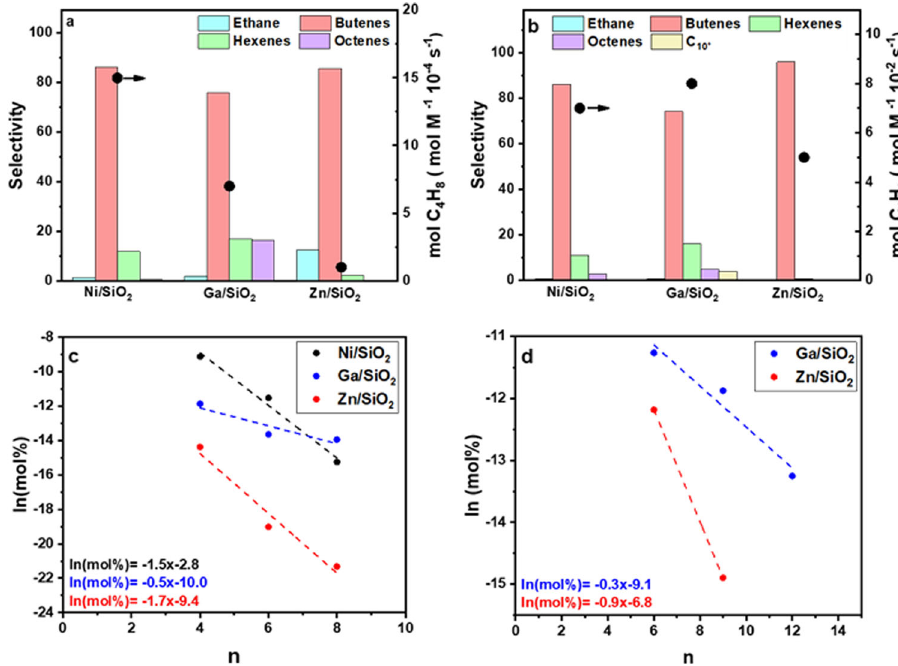
Fig. 2 Ethylene oligomerization product distribution and reaction rate at 250 °C. a 1 atm ( X = ~5%). b 30.6 atm ( X = ~20%). c C 2 H 4 Schultz Flory distribution. d C 3 H 6 Schultz Flory